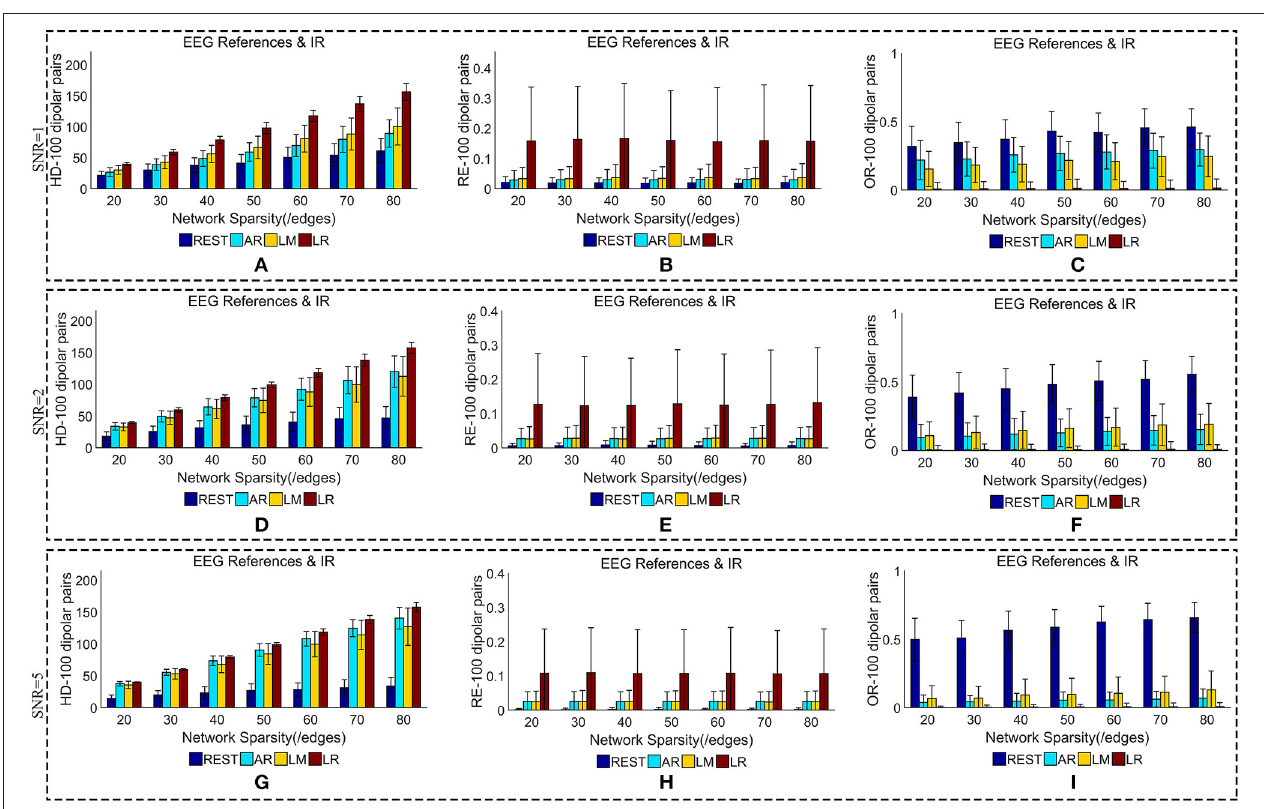
FIGURE 6 | Similarity of sFCTs between EEG references (REST, AR, LM, and LR) and IR based on HD (Hamming Distance), RE (Relative Error), and OR (Overlapping Rate) with various SNR (from 1, 2 to 5). In the case of SNR = 1, different metrics, HD (A) , RE (B) , and OR (C) , were used to measure similarity. In the case of SNR = 2, HD, RE, and OR correspond to (D–F) , respectively. Similarly, in the case of SNR = 3, HD, RE, and OR correspond to (G–I) , respectively. Each bar graph gives results from the four EEG references (REST, AR, LM, and LR) under different network sparsities (ranging from 20 to 80 with an interval of 10).